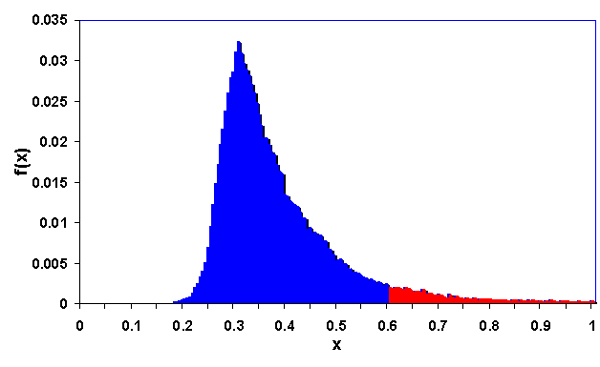
The probability density function of FM d-value. The probability density function of FM d-value shows that most d-values falls into the middle region and only 5% d-values are greater than 0.6058; these d-values are considered significant.